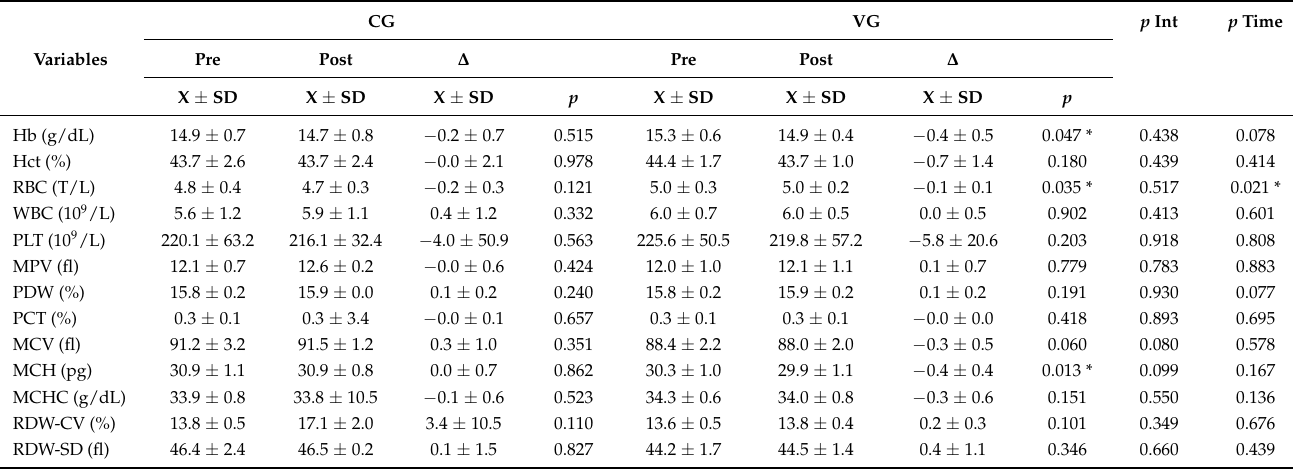
Table 3. Values of blood morphological parameters and their differences ( ∆ ) in the control (CG) and examined (VG) groups, before and after three vibrotherapy series considering interactions between the groups ( p int) and changes over time ( p time). CG VG p Int p Time Variables